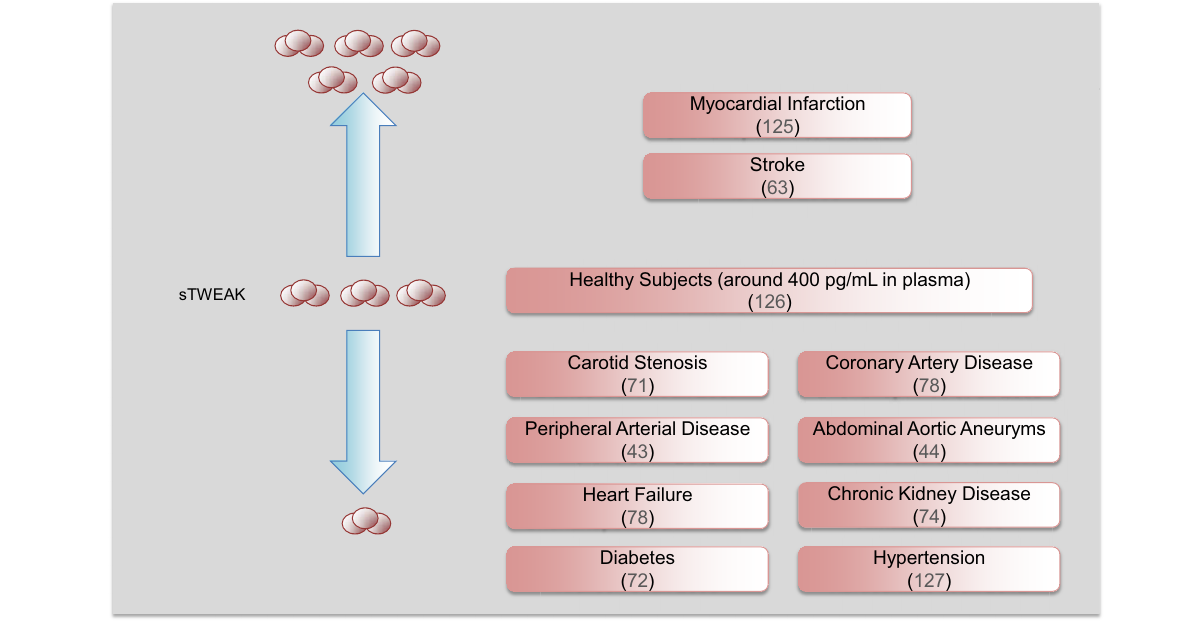
FIGURE 4 | SolubleTWEAK as a biomarker of cardiovascular diseases . Circulating sTWEAK concentrations are diminished in subjects with chronic vascular damage including carotid stenosis, coronary artery disease, peripheral artery disease, abdominal aortic aneurysm, heart failure, and